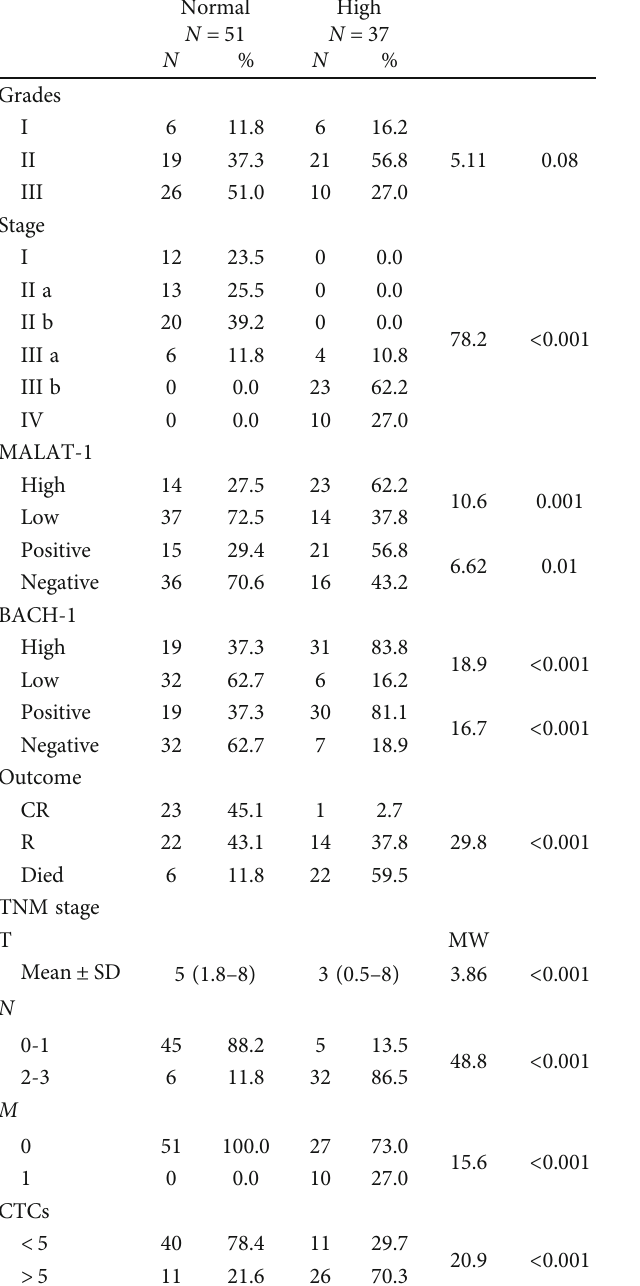
Table 6: Association between monocytic MDSCs and basic characteristics among studied TNBC.